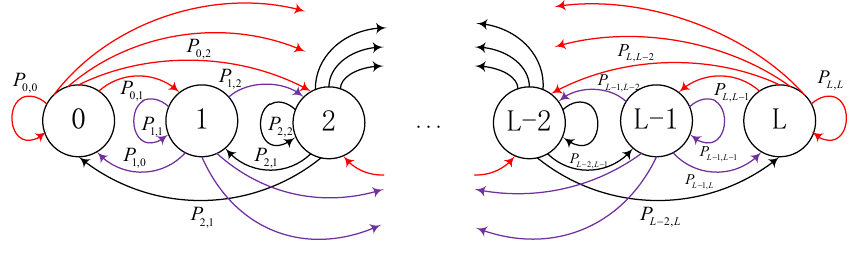
Figure 2. State transition probability of Markov